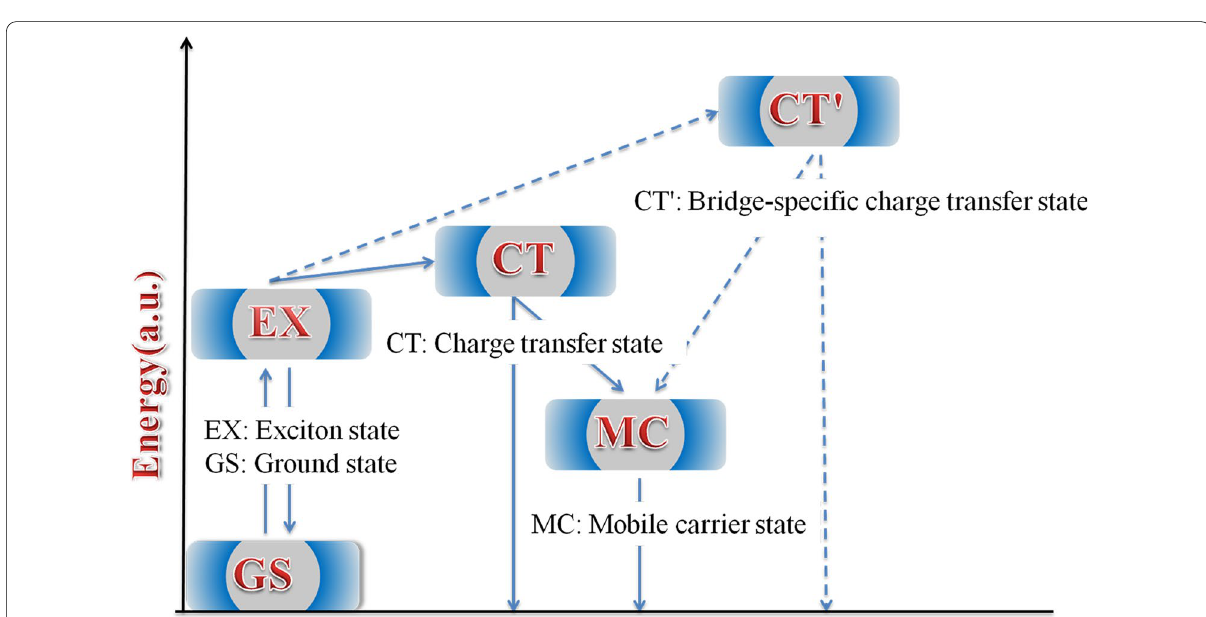
Fig. 8 Schematic illustration of the states and pathways in exciton splitting dynamics of the HSD polymers in